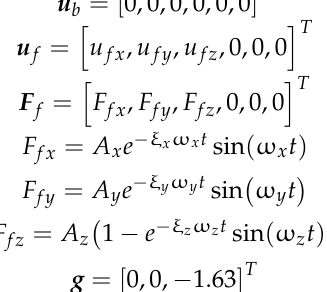
the force boundary condition. The parameter value of F f is listed in Table 2. The lunar gravity is also considered, which is along the opposite direction of the z axis. g is the gravitational acceleration.